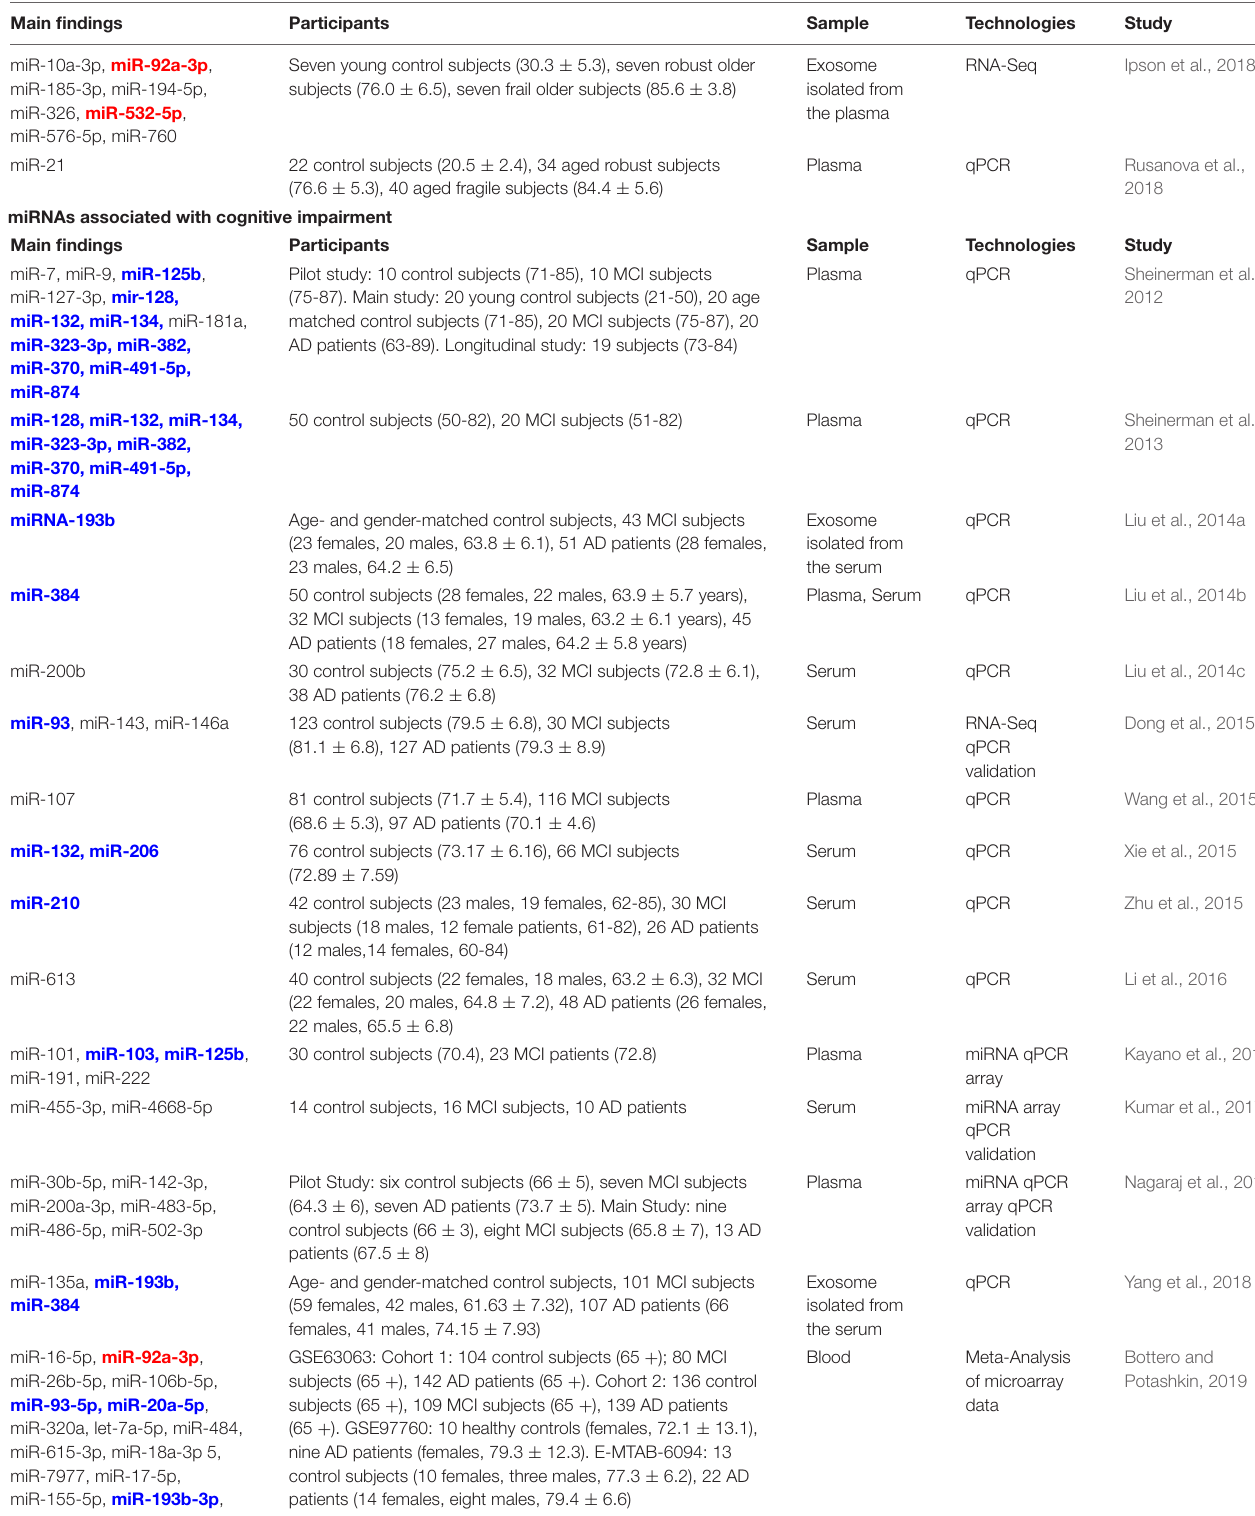
TABLE 1 | Summary of miRNAs associated with frailty and cognitive